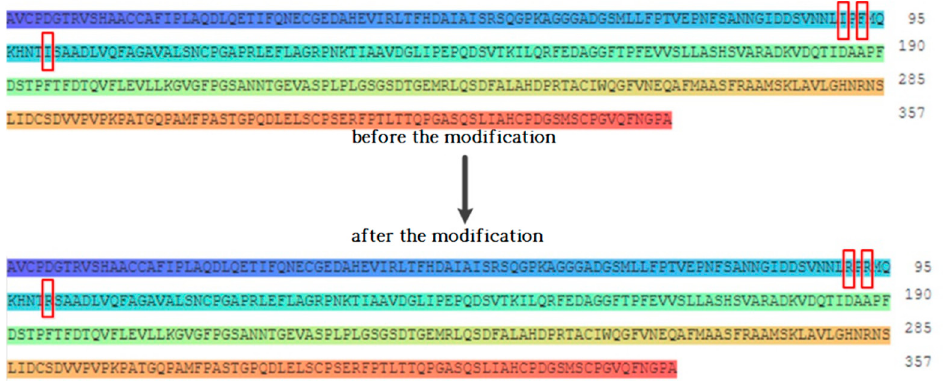
Figure 2. Schematic diagram of amino acid sequence changes before and after modification of degrading enzyme (PDB ID: 1YZP).